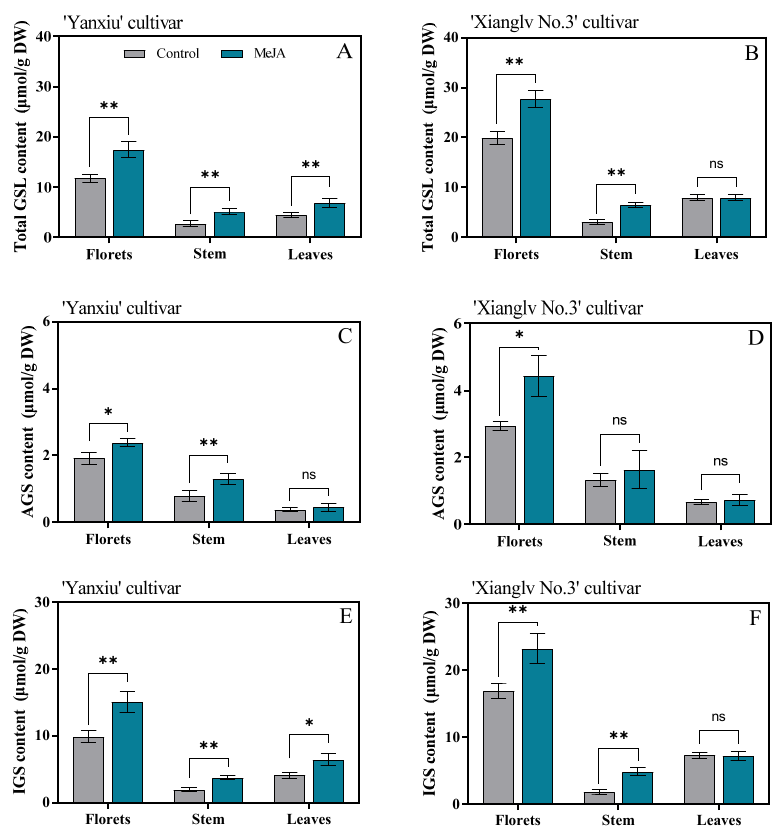
Figure 1. Effects of MeJA on total GSLs ( A , B ), AGS ( C , D ), and IGS ( E , F ) content in broccoli florets, stem, and leaves. GSLs: glucosinolates; AGS: total aliphatic GSLs; IGS: total indole GSLs; DW: dry weight; control: the plants were sprayed with distilled water; MeJA: the plants were sprayed with 40 µ mol/L MeJA. The data are displayed with the mean ± SD of three replications. Values with ns, * and ** are significantly different at p > 0.05, p < 0.05, and p <